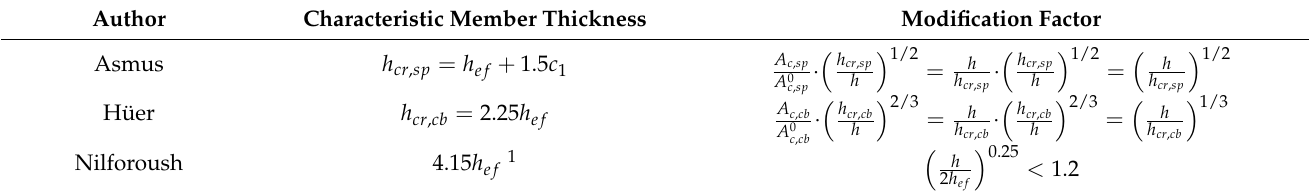
Table 1. Comparison between modification factors for the influence of member thickness that can be found in the literature